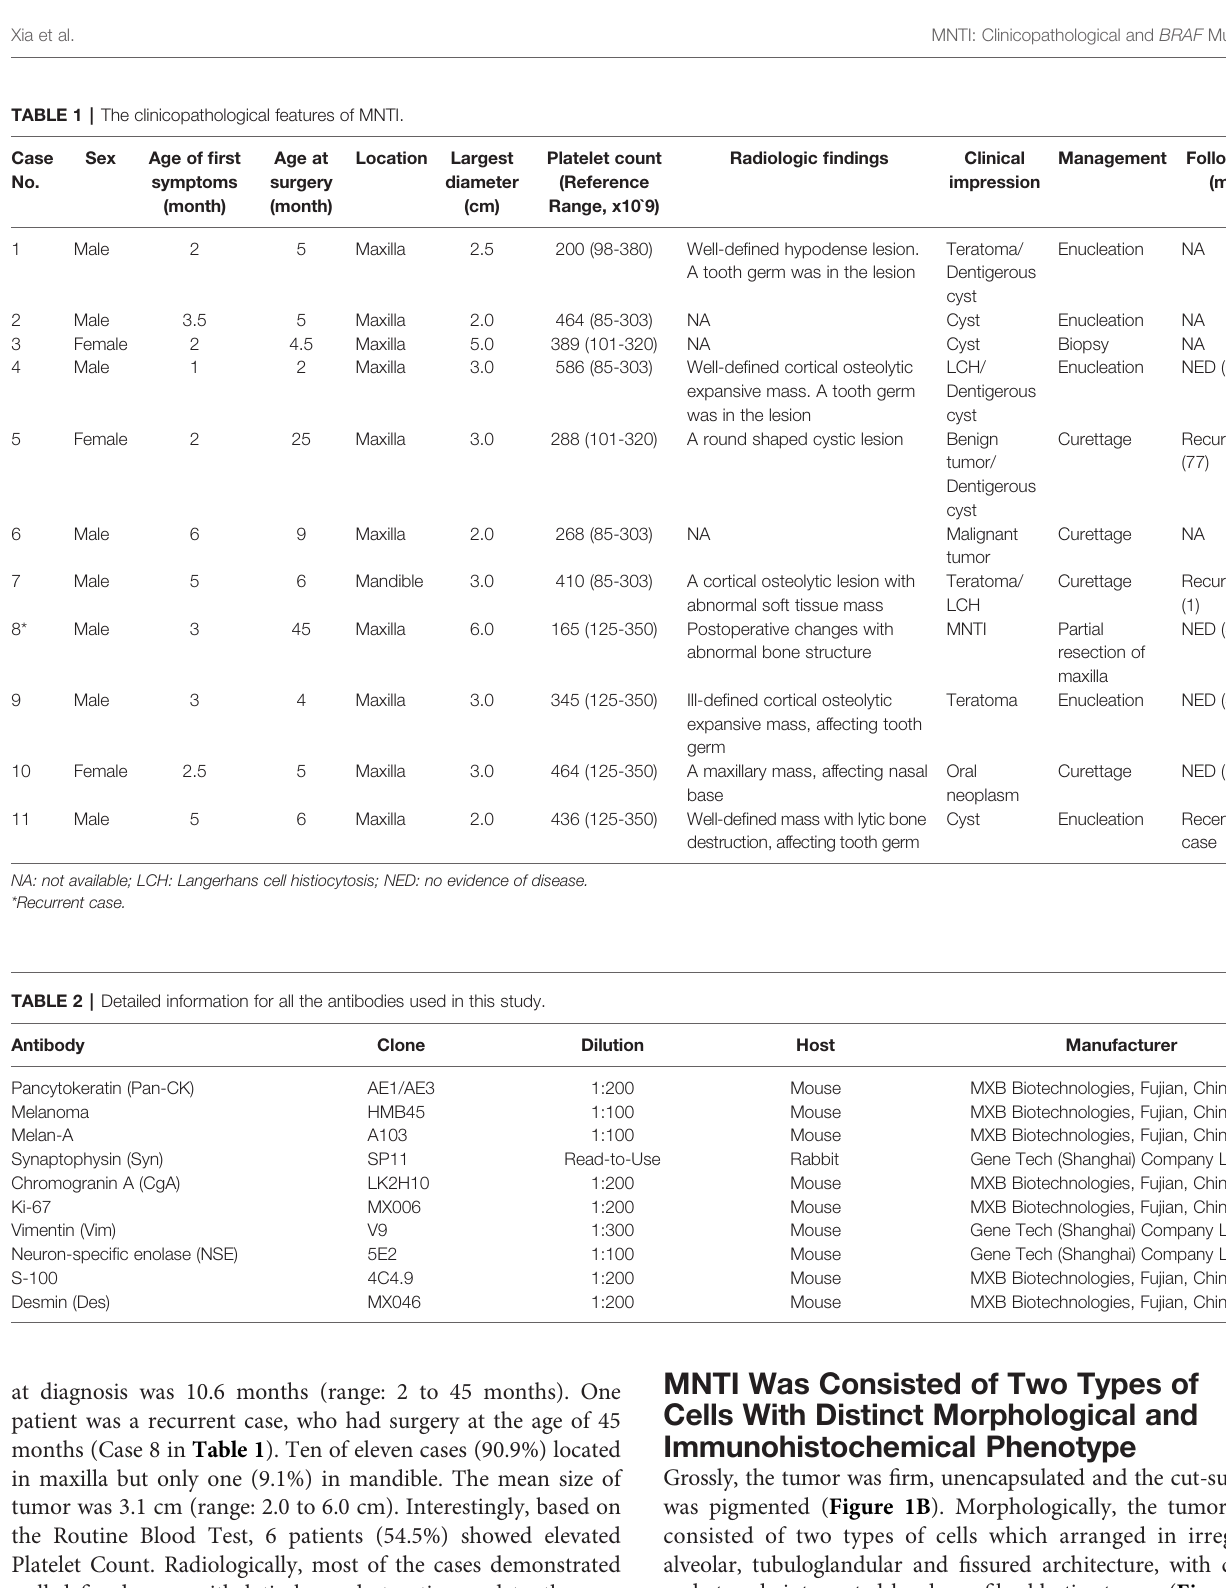
TABLE 1 | The clinicopathological features of MNTI. Case No.